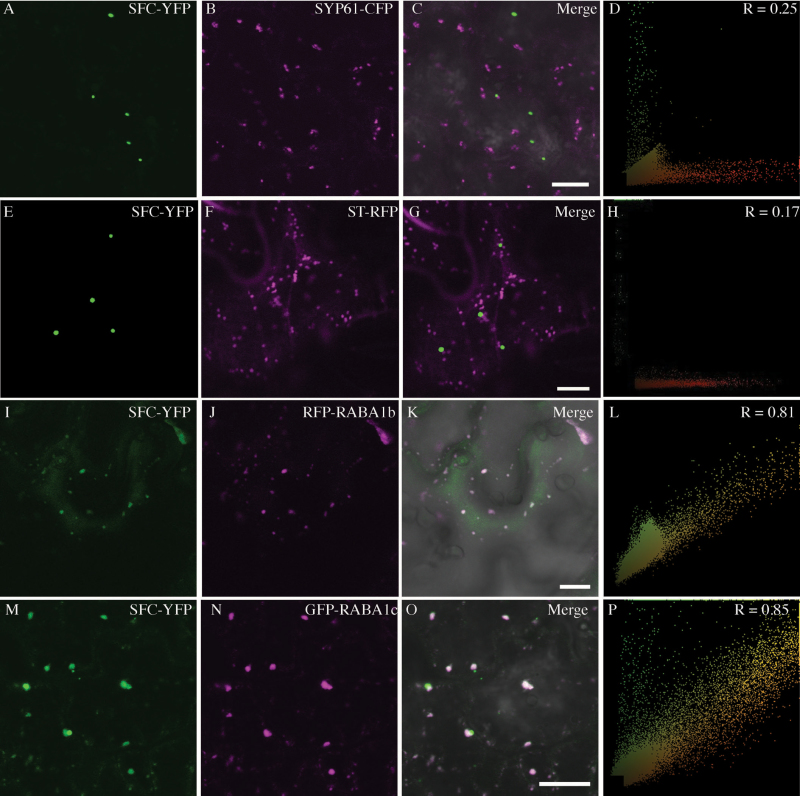
35S:SFC–YFP localizes moderately with the TGN marker SYP61pro:SYP61–CFP and strongly with RABA-GTPases. Localization of 35S:SFC–YFP with the TGN marker marker SYP61pro:SYP61–CFP (A–D), the Golgi marker 35S:ST–RFP (E–H), or secretory markers 35S:RFP–RABA1b (I–L) and 35S:GFP–RABA1c (M–P) in stably transformed 2.5 DAG Arabidopsis cotyledon pavement cells (A–D and M–P), transiently expressing Nicotiana tabacum leaf epidermal cells (E–H) or transiently expressing Nicotiana benthamiana leaf epidermal cells (I–L). (A), (E), (I), and (M) 35S:SFC–YFP alone; (B) SYP61pro:SYP61–CFP alone; (F) 35S:ST–RFP alone; (J) 35S:RFP–RABA1b alone; (N) 35S:GFP–RABA1c alone; (C), (G), (K), and (O) merged images; (D), (H), (L), and (P) scatter plots of the merged image with Pearson’s coefficient of correlation (R) values. Scale bar=10 μm.